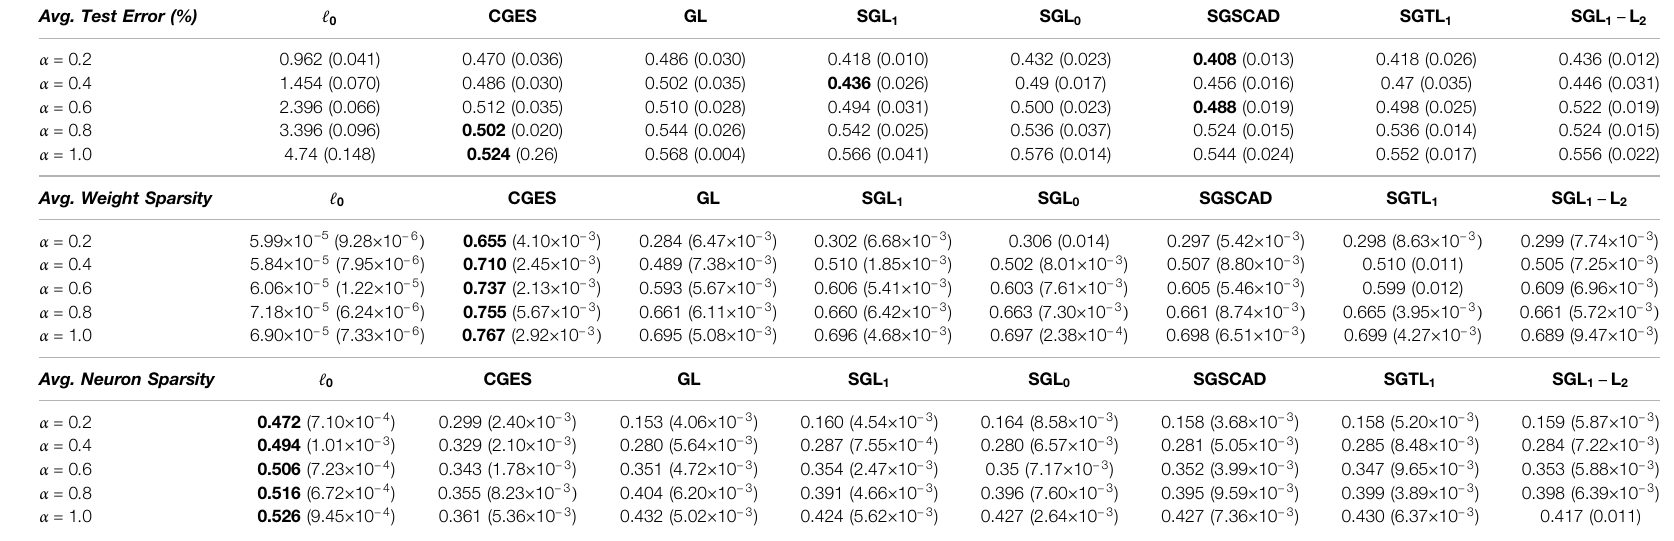
TABLE 4 | Average test error, weight sparsity, and neuron sparsity of 4-layer CNN models trained on MNIST after 200 epochs across 5 runs. Standard deviations are in parentheses. Avg. Test Error